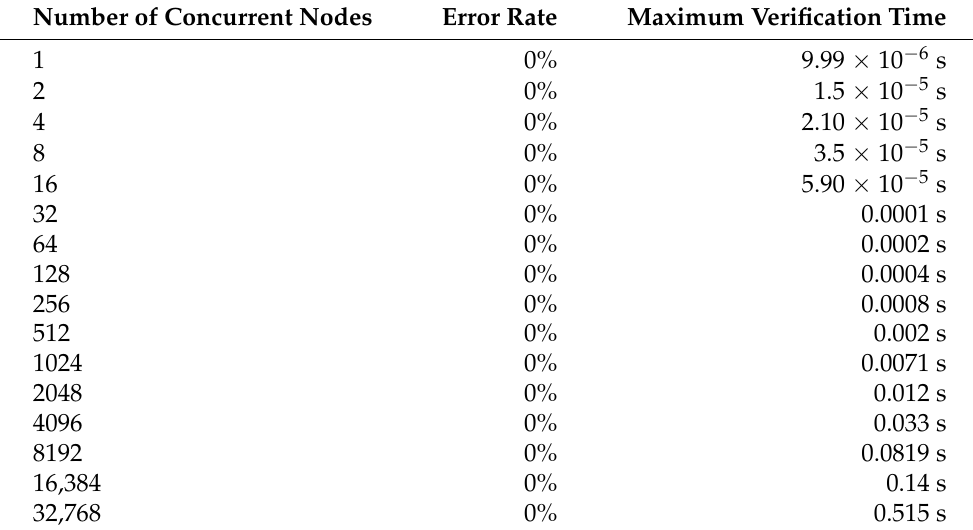
Table 7. Blockchain node